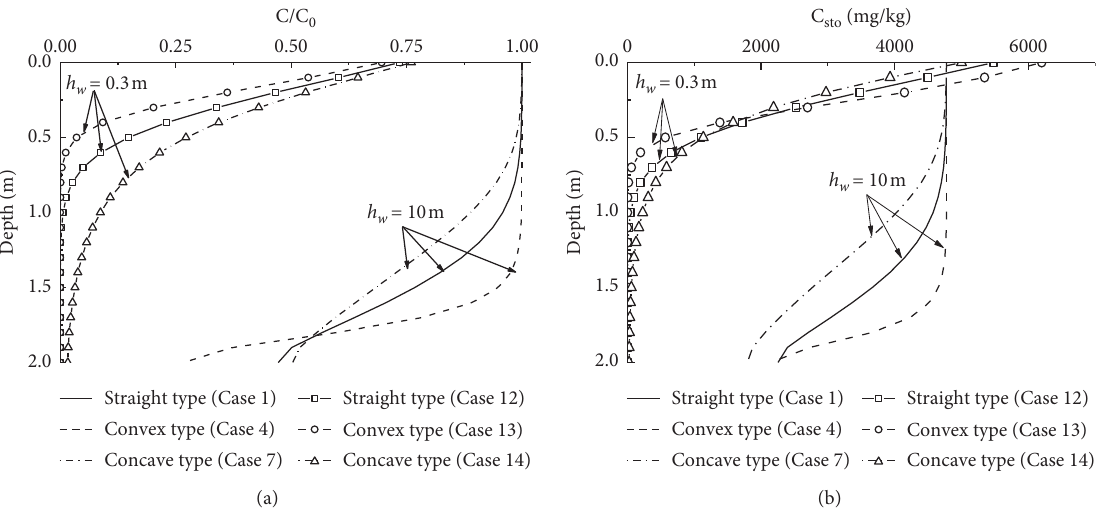
Figure 6: Comparison of pore water concentration and total soil concentration with different waterheads (50 years). (a) Pore water concentration profiles. (b) Total concentration in soil profiles.